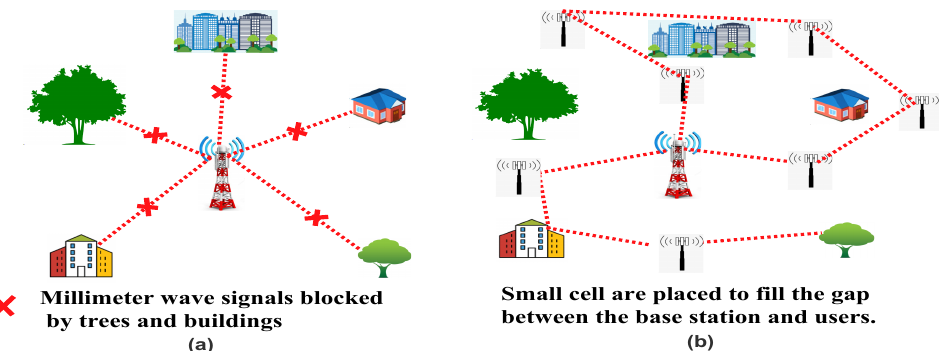
Figure 7. Pictorial representation of communication with and without small